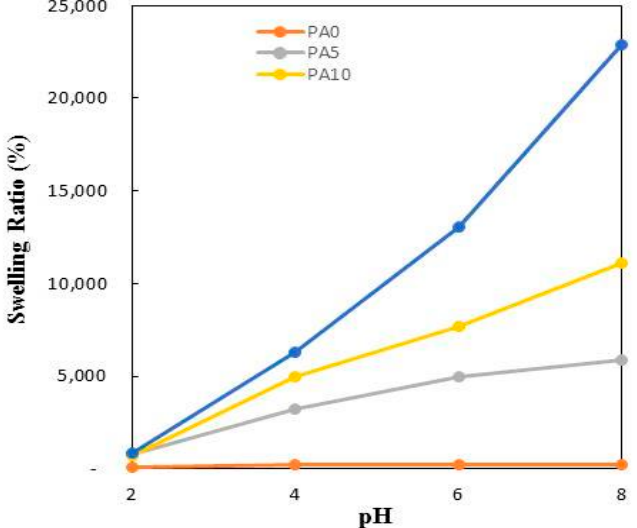
Figure 8. Effect of pH on swelling ratio PA hydrogels prepared at radiation dose 30 kGy.